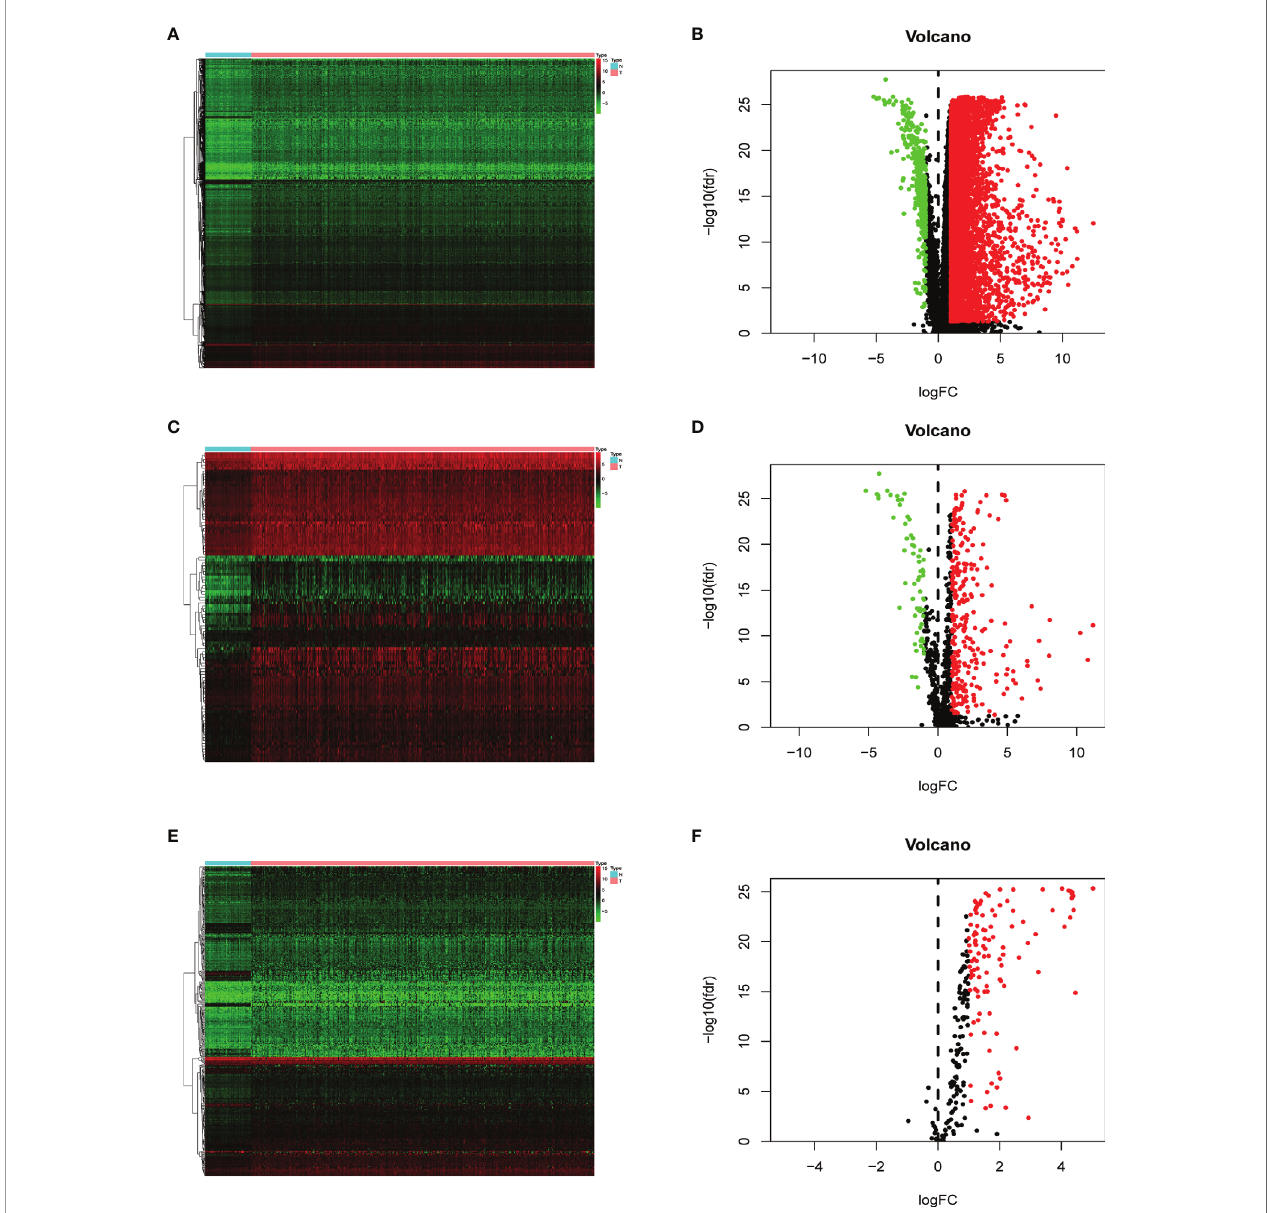
FIGURE 2 | Heat map (A) and volcano map (B) of differentially expressed genes; heat map (C) and volcano map (D) of immune differential genes; heat map (E) and volcano map (F) of differentially expressed genes related to the signal transduction pathway of P53 mediators. The abscissa of the heat map represents the sample: the blue area represents the adjacent tissue, the red area represents the hepatocellular carcinoma tissue; the ordinate represents the gene. The red dots on the volcano map represent genes whose expression levels are up-regulated, and the green dots represent genes whose expression levels are